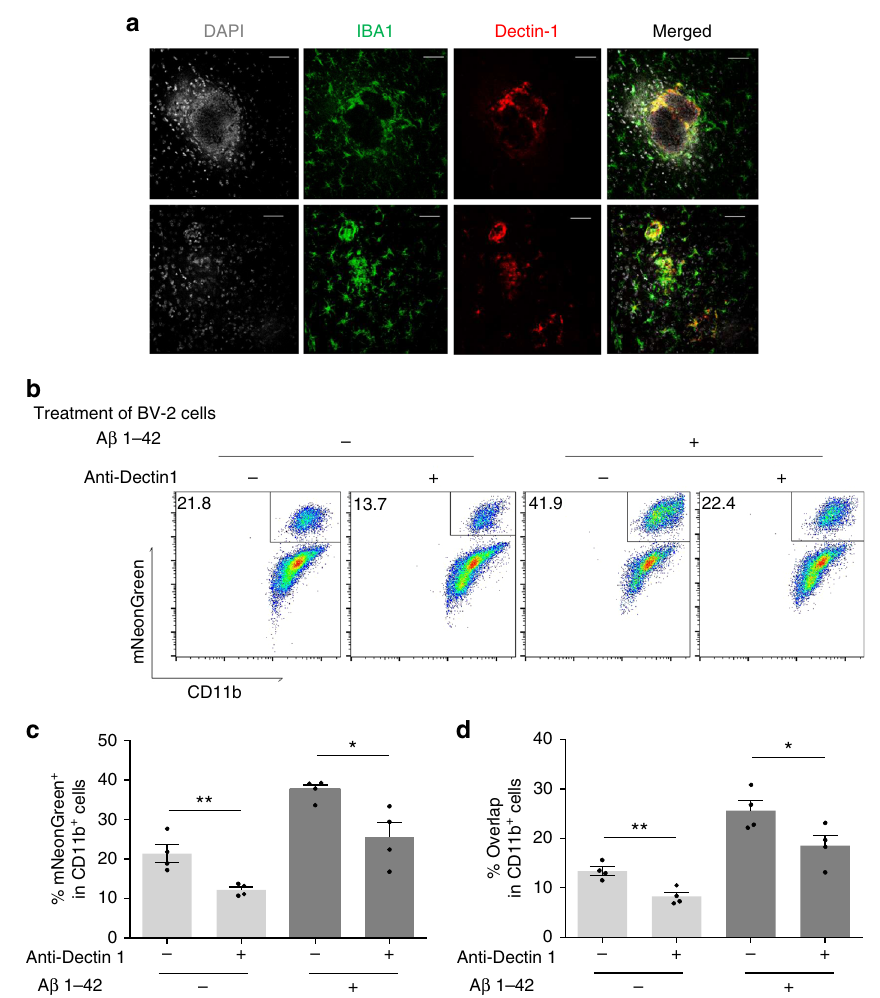
Fig. 7 Dectin-1 expression is associated with FIGGs. a Wild-type mice were challenged with C. albicans as in Fig. 2, and immuno fl uorescence staining for DAPI, IBA1, and Dectin-1 was performed on brain sections containing FIGGs. b Representative fl ow plot from the ImageStream X of treated BV-2 cells (A β or Dectin-1 blocking antibody) co-cultured with mNeonGreen + C. albicans . c Percentage of mNeonGreen + cells in all CD11b + cells. d Percentage of overlap cells in all CD11b + cells with the same gating strategy in Fig. 6. ( n = 4, mean ± S.E.M, * p < 0.01, ** p < 0.01 using one-way ANOVA followed by Dunnett ’ s test for multiple comparison. Data are shown as representative of two independent